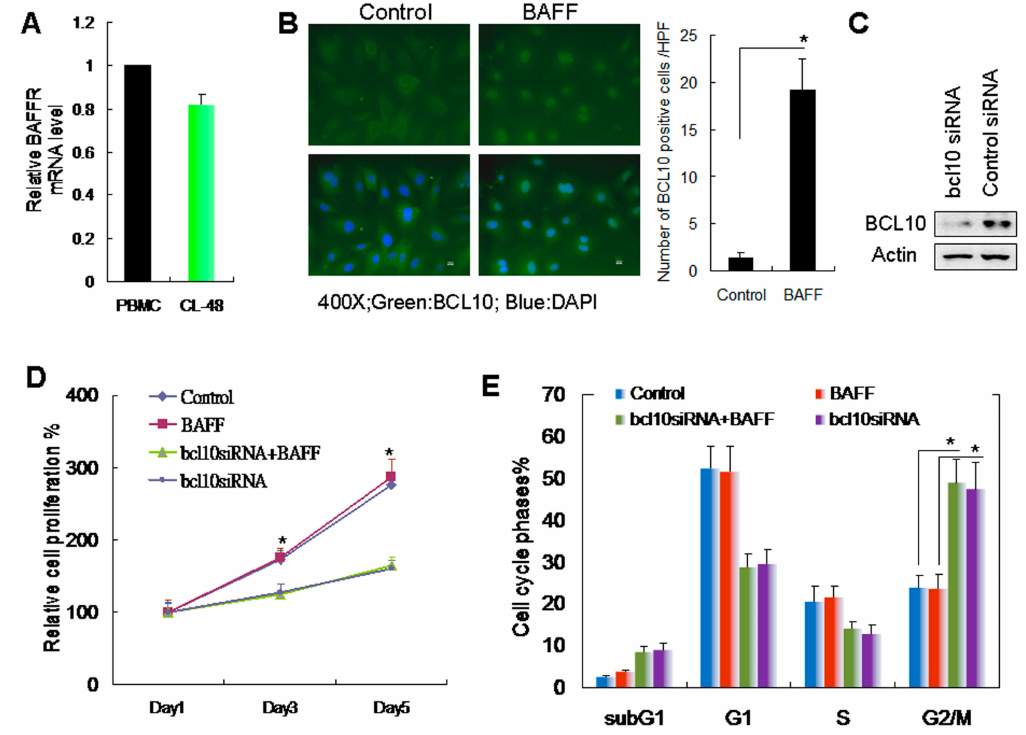
Figure 2. BAFF / BCL10 signaling in hepatocye cell proliferation. ( A ) The expression of BAFFR mRNA in human CL-48 hepatocytes was determined by q-Reverse Transcription Polymerase Chain Reaction (q-RT-PCR); commercialized human peripheral blood mononuclear cells (PBMC) cDNA was used as the positive control. ( B ) Left panel, human CL-48 hepatocytes were treated without (control) or with BAFF (1 ng / mL) for 1 h, and the expression of BCL10 was determined by immunofluorescence staining; BCL10 was identified as a green signal, and the nucleus was stained with DAPI (blue). Magnification, 400 × . Right panel, the number of BCL10 positive cells was counted under high power field (HPF). n = 6. * p < 0.05, by Student’s t -test. ( C ) CL-48 cells were treated with control or with BCL10 siRNA for 24 h; the expression of BCL10 was determined by western blotting. Actin was used as the loading control. ( D ) CL-48 cells were treated with control or BCL10 siRNA for 24 h prior treatment with BAFF (1 ng / mL). At di ff erent time points, relative cell proliferation was determined by the Trypan blue exclusion assay. The data are shown as mean ± SD of three independent experiments. Comparisons were made between the BAFF and bcl10siRNA + BAFF groups. * p < 0.05, by Student’s t -test. ( E ) CL-48 cells were